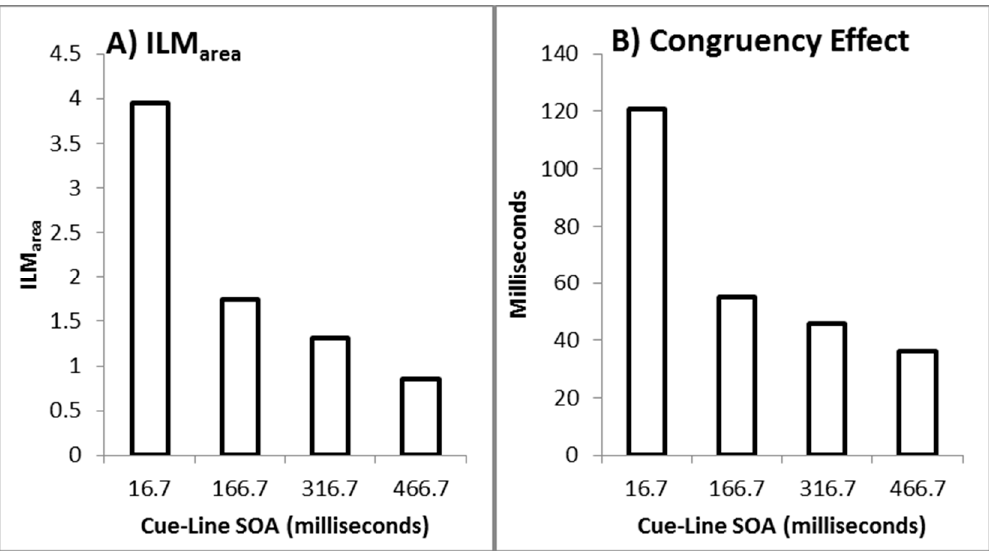
Figure 3. Mean A ) illusory line motion (ILM area ) and B ) decision time congruency effect from Figure 3. Mean ( A ) illusory line motion (ILM area ) and ( B ) decision time congruency effect from Experiment 1 for cue-bar ISIs of 16.7 ms, 166.7 ms, 316.7 ms, and 466.7 ms. Experiment 1 for cue-bar ISIs of 16.7 ms, 166.7 ms, 316.7 ms, and 466.7